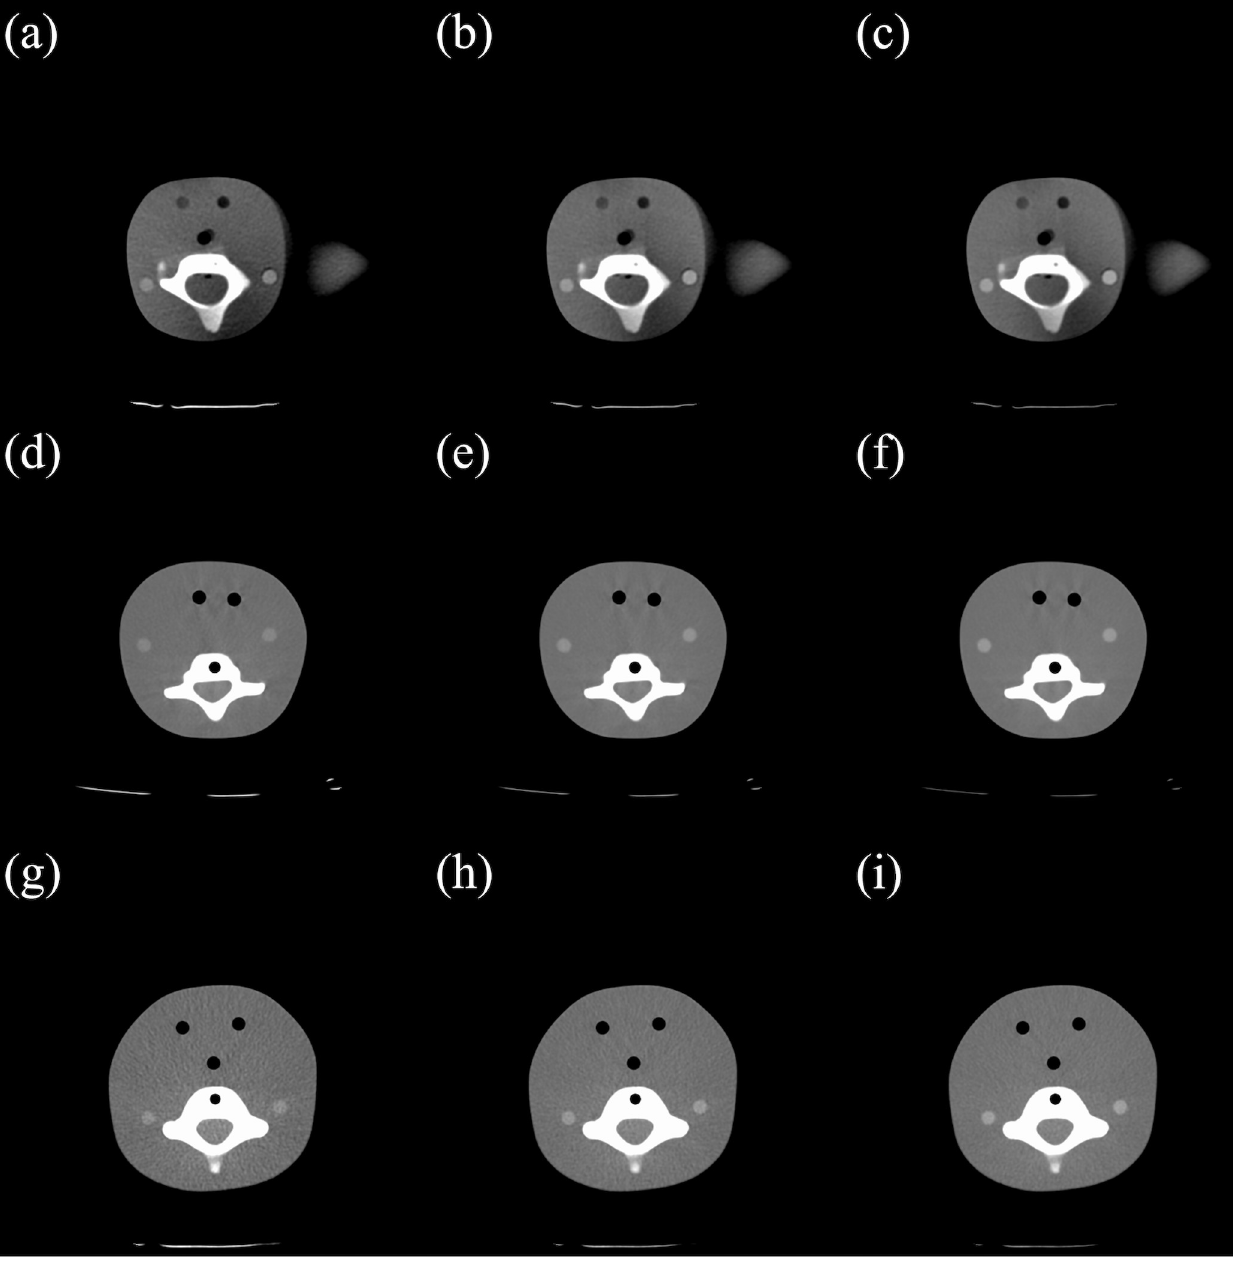
Fig 2. Computed tomography images of the phantom at the level of the upper neck obtained with different voltage protocols. The difference in the measured image noise was the greatest at this level: (a) 1-, (d) 5-, and (g) 10-year-old, 80 kVp; (b) 1-, (e) 5- and (h) 10-year-old, 100 kVp; (c) 1-, (f) 5-, and (i) 10-year-old, 120